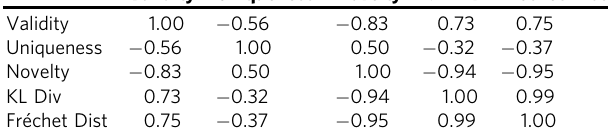
Table 1 Spearman ’ s correlation coef fi cient between benchmark metrics for results using the masked graph model on the QM9 dataset.